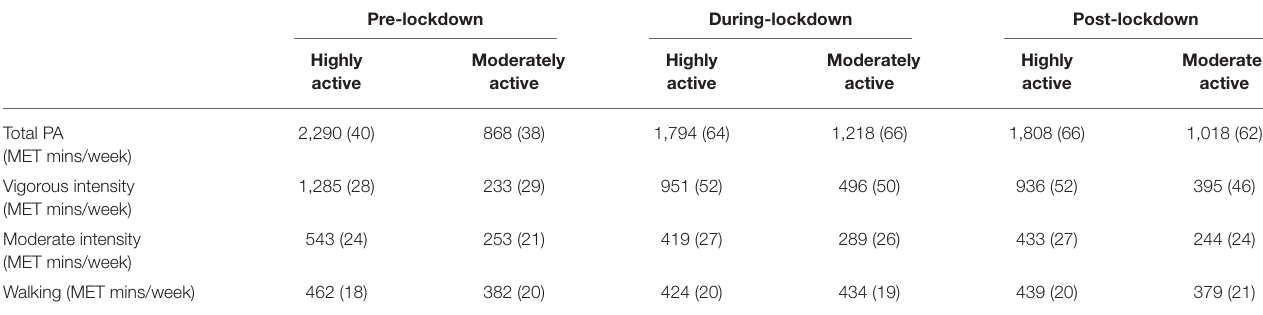
TABLE 2 | Mean (SE) physical activity pre-lockdown, during-lockdown, and